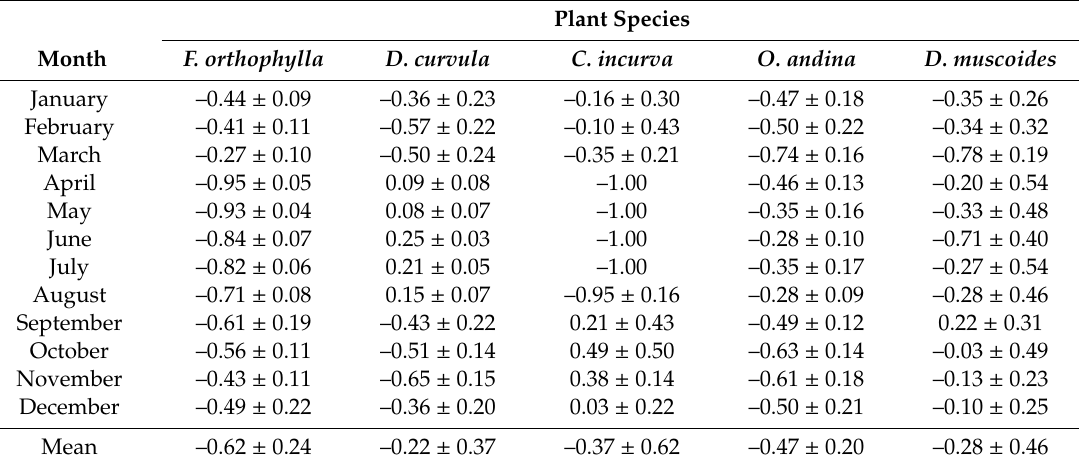
Table 3. Ivlev’s selectivity index (monthly averages ± standard deviation) for relevant species in the vicuña diet, which have important participation in the botanical composition of the grassland 1 .